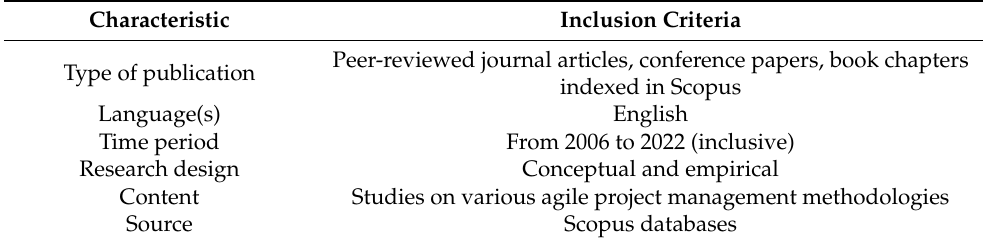
Table 1. Criteria for